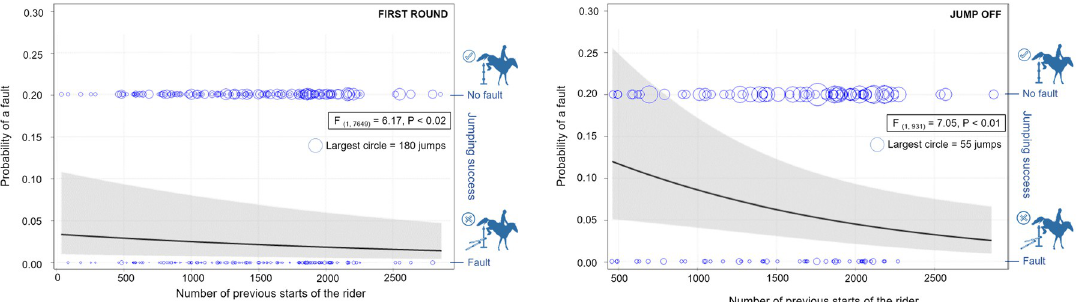
Fig 4. Predicted probability of a fault according to the experience of the rider. Predicted probability of a fault according to the experience of the rider in the first round (left) and jump off (right). The line and grey field show the predicted probability of a fault ± 95% confidence limit. Two rows of circles represent raw data of numbers of faults (bottom row) or successful jumps (upper row) corresponding to the number of previous starts of the rider. Circle size reflects the number of observations on a particular number of the riders’ previous starts.